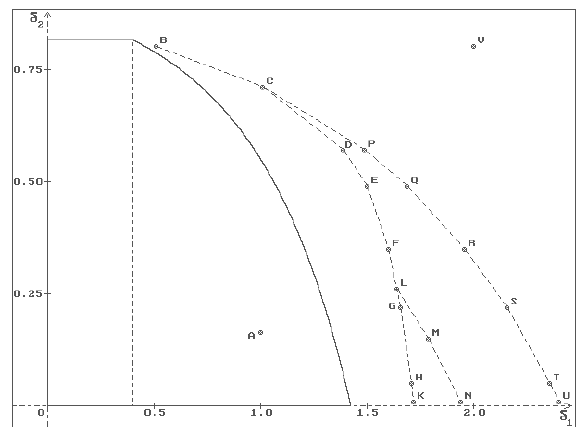
Figure 1. Stability region for the equilibrium E + = ( S ∗ , I ∗ , R ∗ ) of the system (6) defined by (9), (10) (solid line) and stability points obtained via LMI (19) (B-K), LMI (26) (L-N) and LMI (33) (B-U).